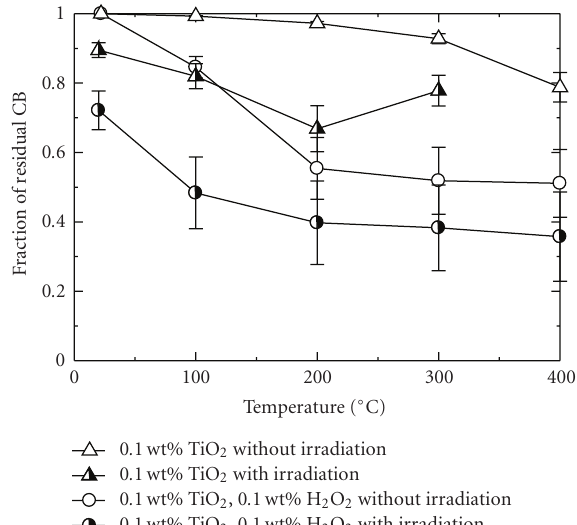
Figure 5: The fraction of residual chlorobenzene (CB) with and without near-UV irradiation at di ff erent temperatures. Flow rate 1.0 cm 3 min − 1 and P = 30 MPa. CB = 1mM; (cid:2) : 0.1wt% TiO 2 without near-UV irradiation (taken from Figure 2); : 0.1 wt% TiO 2 with near-UV irradiation; : 0.1wt% TiO 2 + 0.1wt% H 2 O 2 without near-UV irradiation (taken from Figure 3); : 0.1 wt% TiO 2 +0.1 wt% H 2 O 2 with near-UV